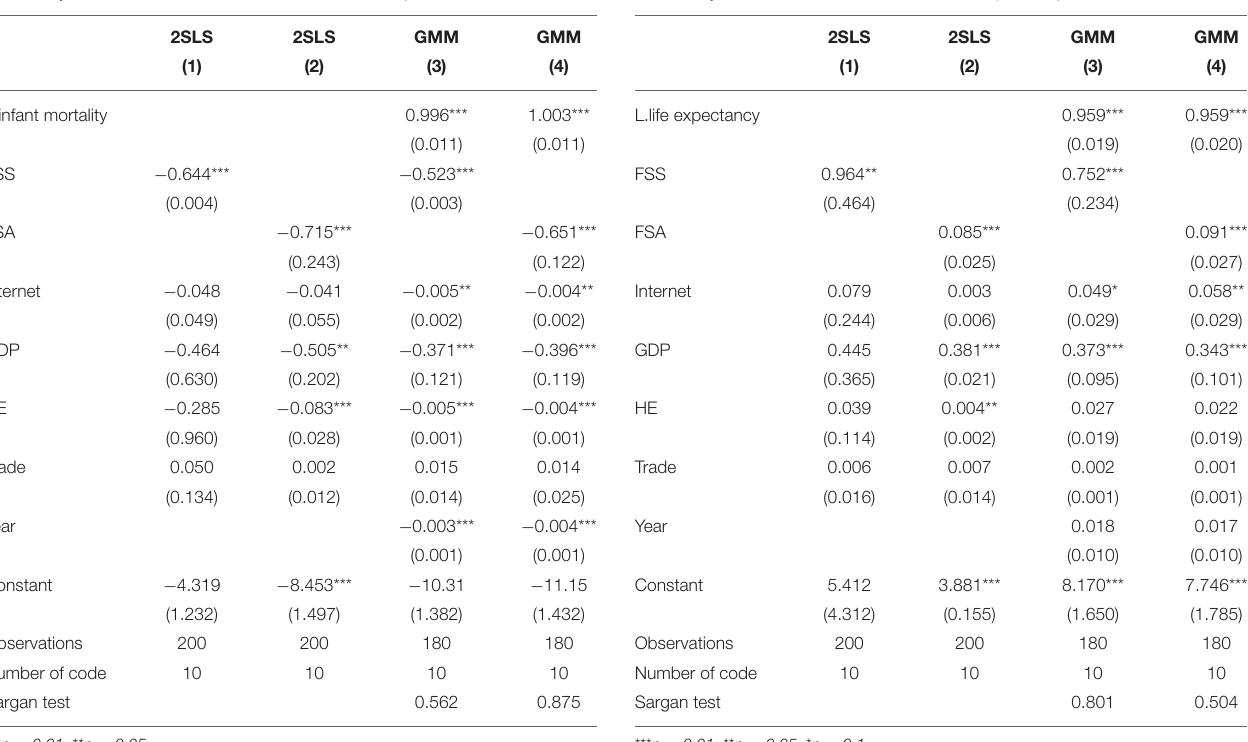
TABLE 3 | Effects of financial structure on infant mortality. TABLE 4 | Effects of financial structure on life